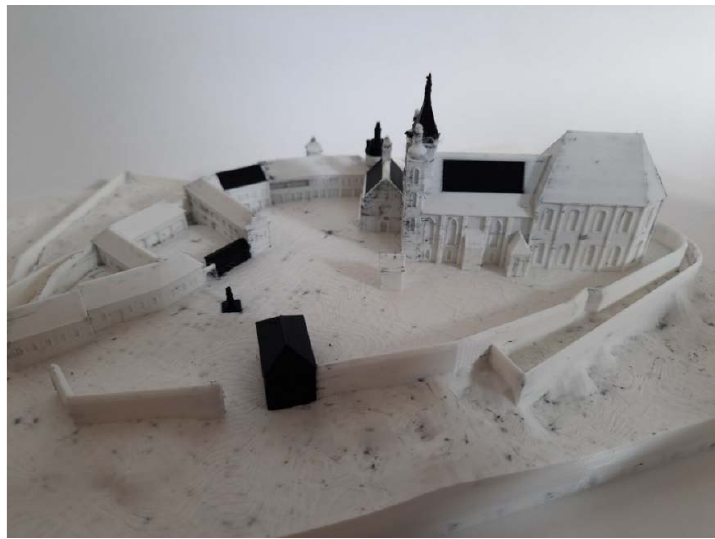
Figure 7. The main segment of the resulting 3D model, composed of conductive and non ‐ conductive parts. The conductive parts react to touch.